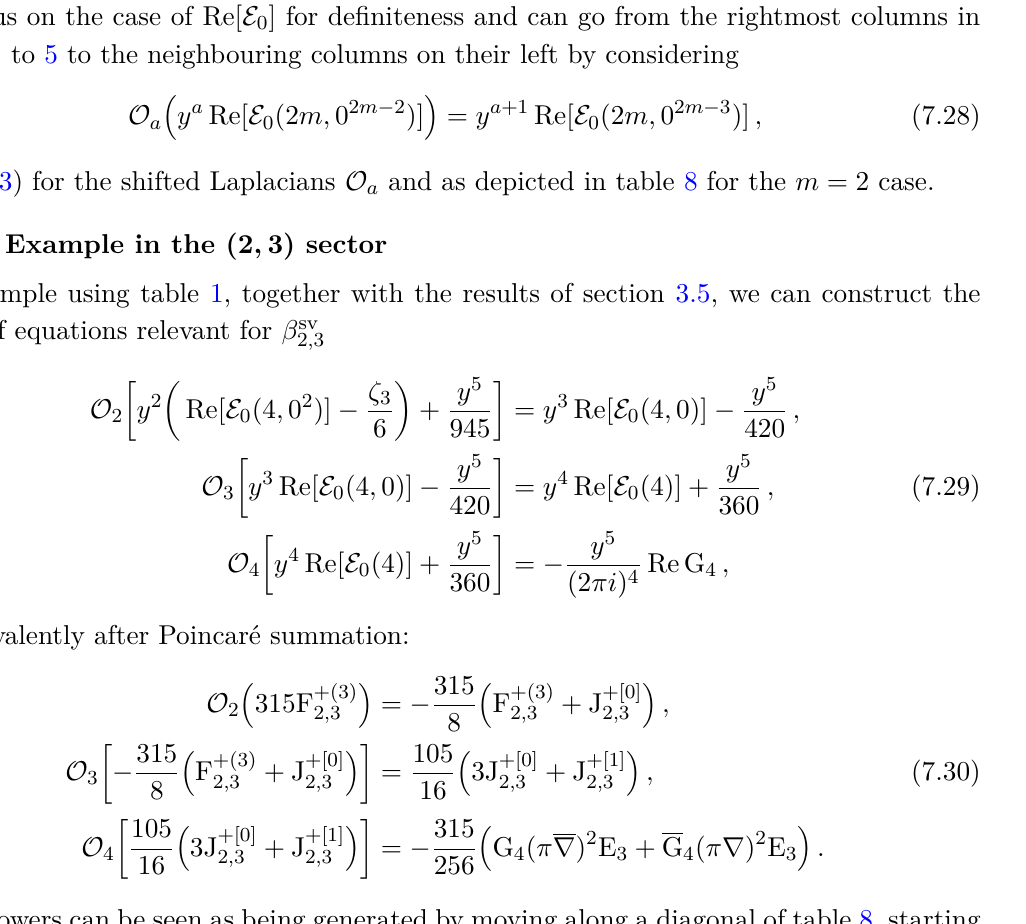
We focus on the case of Re[ E ] for definiteness and can go from the rightmost columns in 0 tables 1 to 5 to the neighbouring columns on their left by